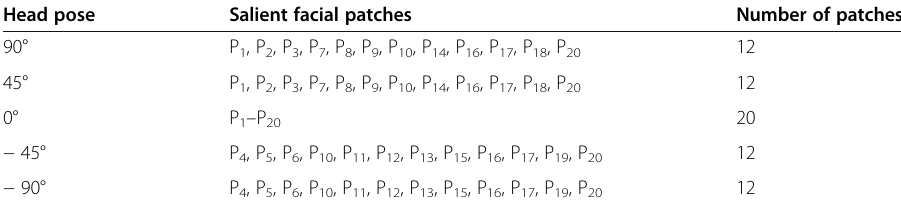
Table 1 Salient facial patches under different head poses Head pose Salient facial